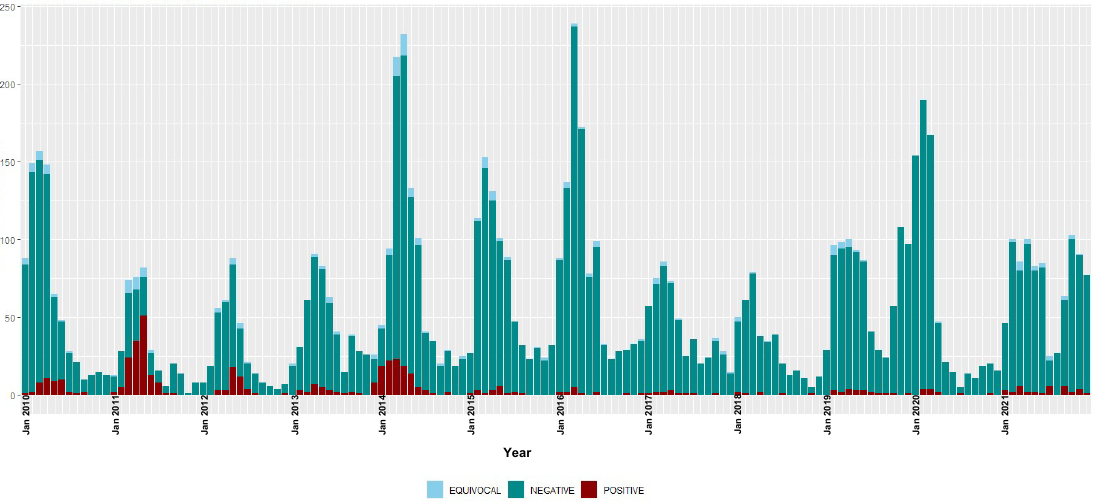
Figure 2. Temporal distribution of rubella IgM-positive, equivocal and negative cases, 2010–2021. Bars are stacked and total bar height represents the number of suspected cases tested for rubella IgM.